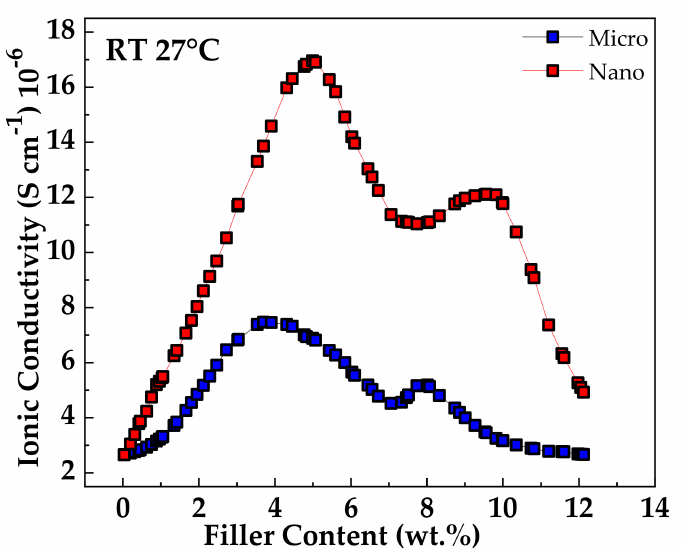
Figure 10. Active filler concentration-dependent conductivity variation for NCPE films: [80PEO: 20Mg(Tf) 2 ] + xMgO micro/nano. Reproduced with permission from Mater. Chem. Phys., 139, Agrawal et al., Investigations on ion transport properties of hot-press cast magnesium ion conducting Nano-Composite Polymer Electrolyte (NCPE) films: Effect of filler particle dispersal on room temperature conductivity, 410–415, 2013